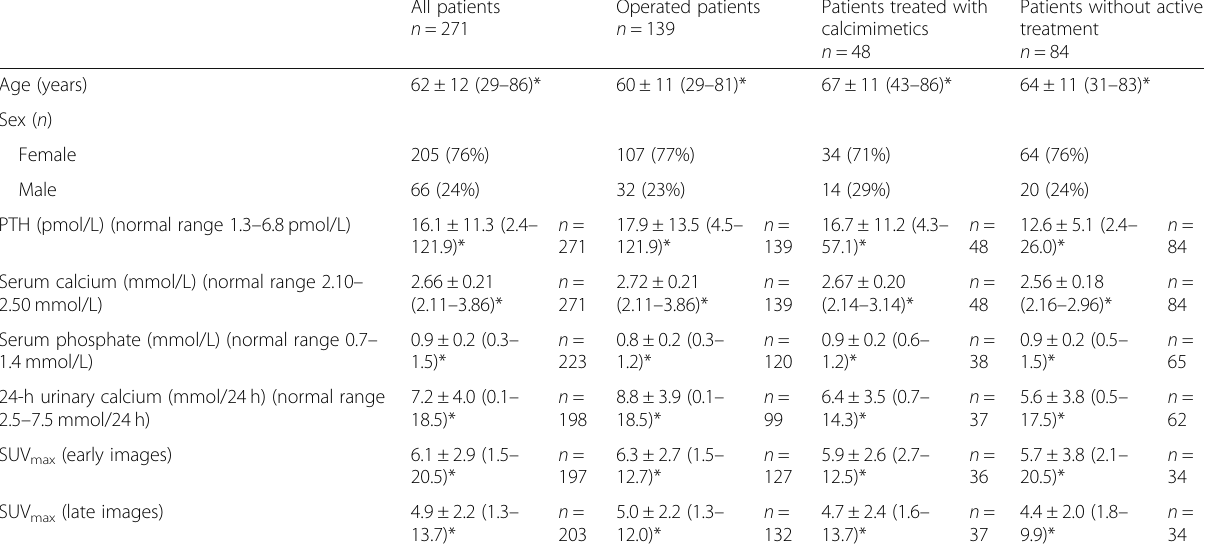
Table 1 Patient characteristics